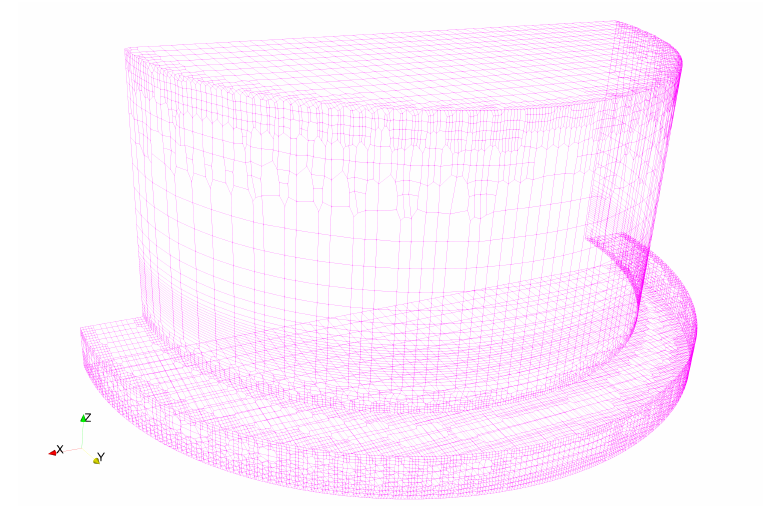
Figure 8. Generated mesh of the floater.